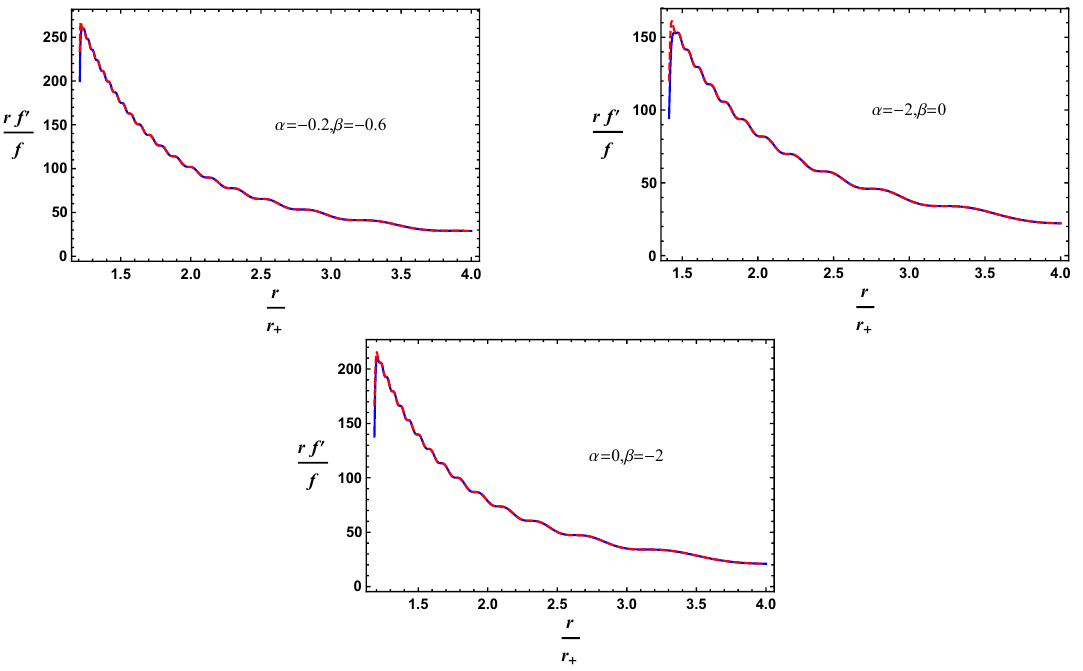
Figure 7 . A comparison of the numerical solution (solid blue curves) of rf 0 /f and fits to the analytic relation (4.7)(red dashed curves) describing Josephson oscillations. Here we have chosen T/T c = 0 . 995 and κ/µ = 1